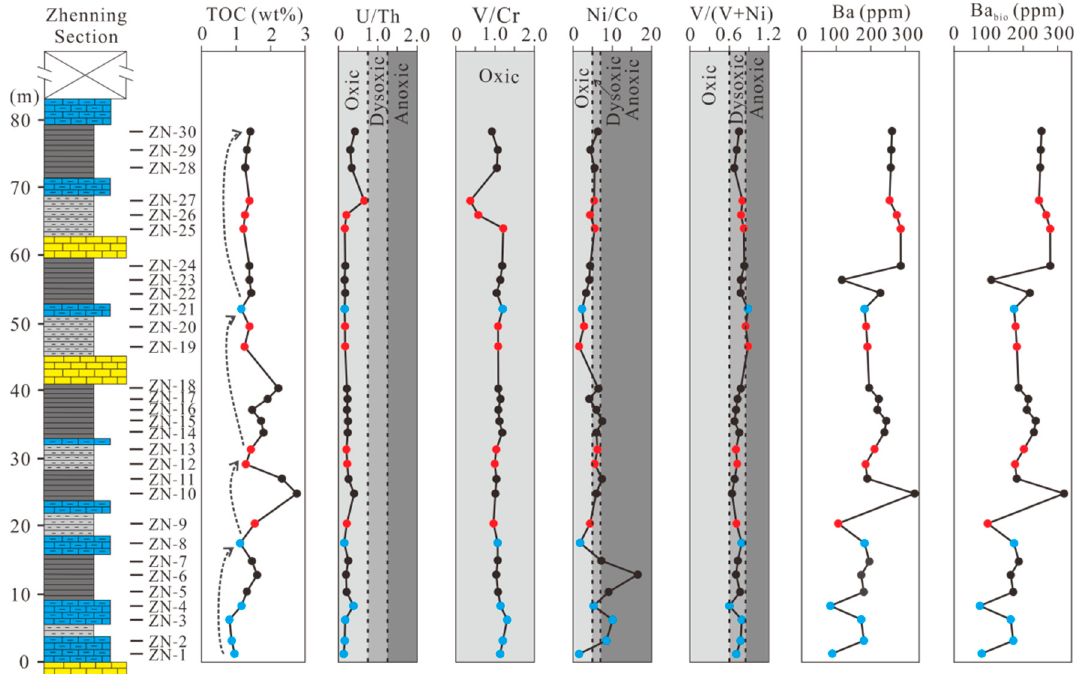
Figure 11. Stratigraphic profiles of Zhenning section for TOC, U/Th, V/Cr, Ni/Co, V/(V + Ni), Ba, and Ba bio . Redox thresholds of U/Th (0.75, 1.25), V/Cr (2.0), and Ni/Co (5.0, 7.0) are from [61]; That thresholds of V/(V + Ni) (0.6, 0.85) are from [60].